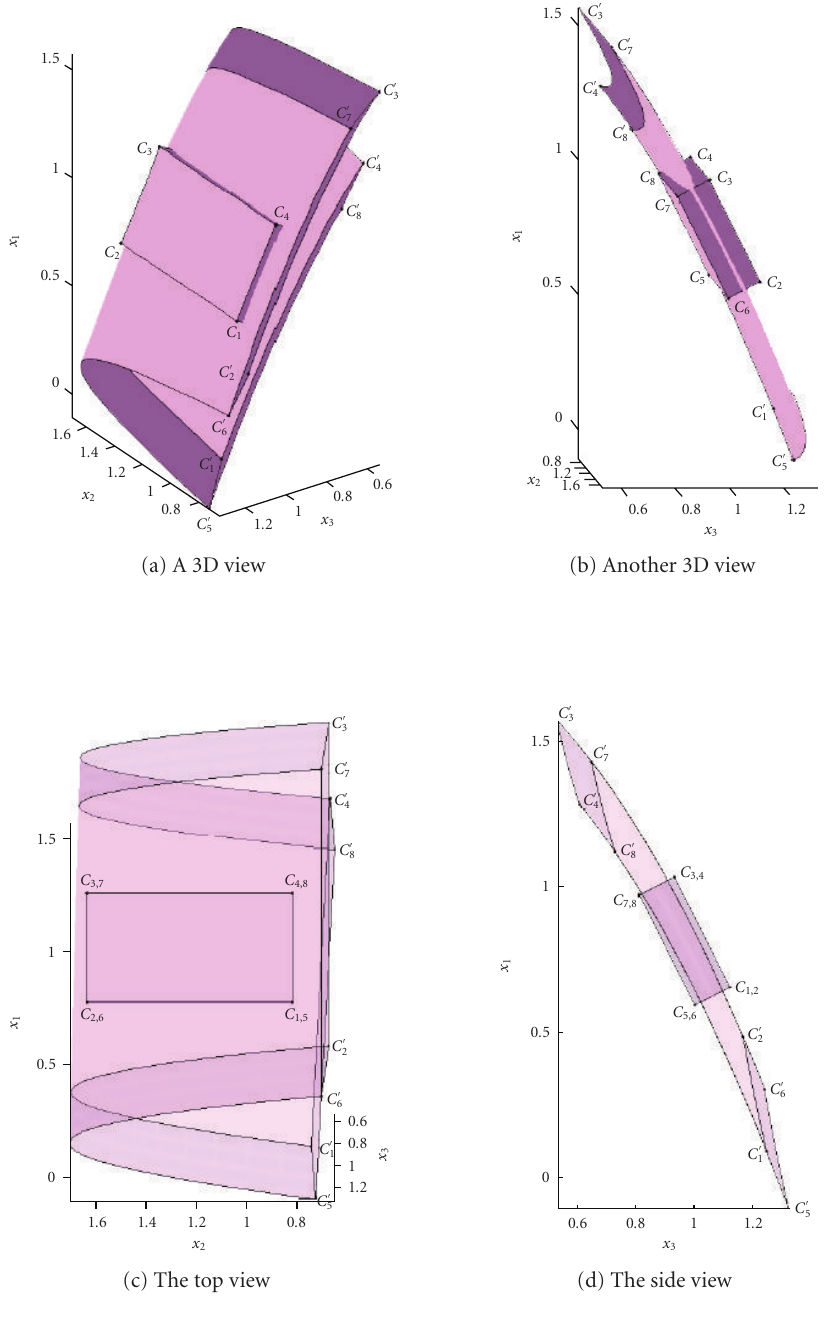
Figure 3.2. Cuboid c and its image under H 4